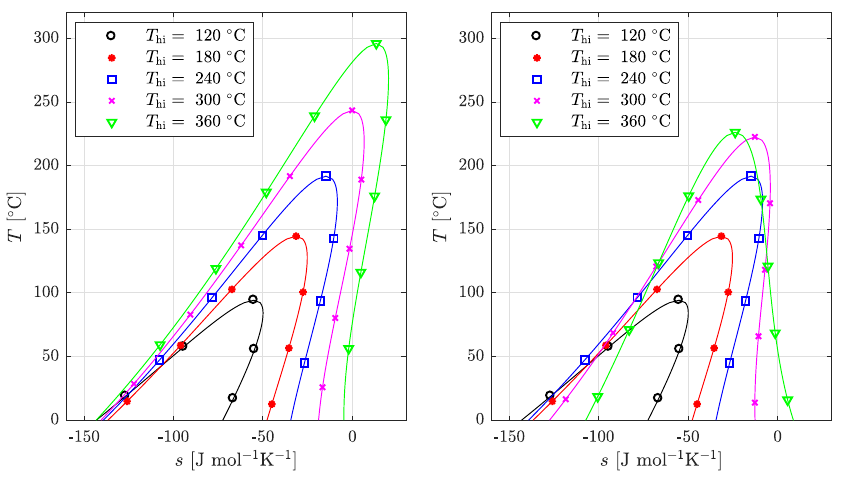
Figure 6. Saturation curves for the optimal working fluids obtained from the cycle optimisation for the unconstrained ( left ) and constrained ( right ) condensation pressure cases with ω = 0.3.